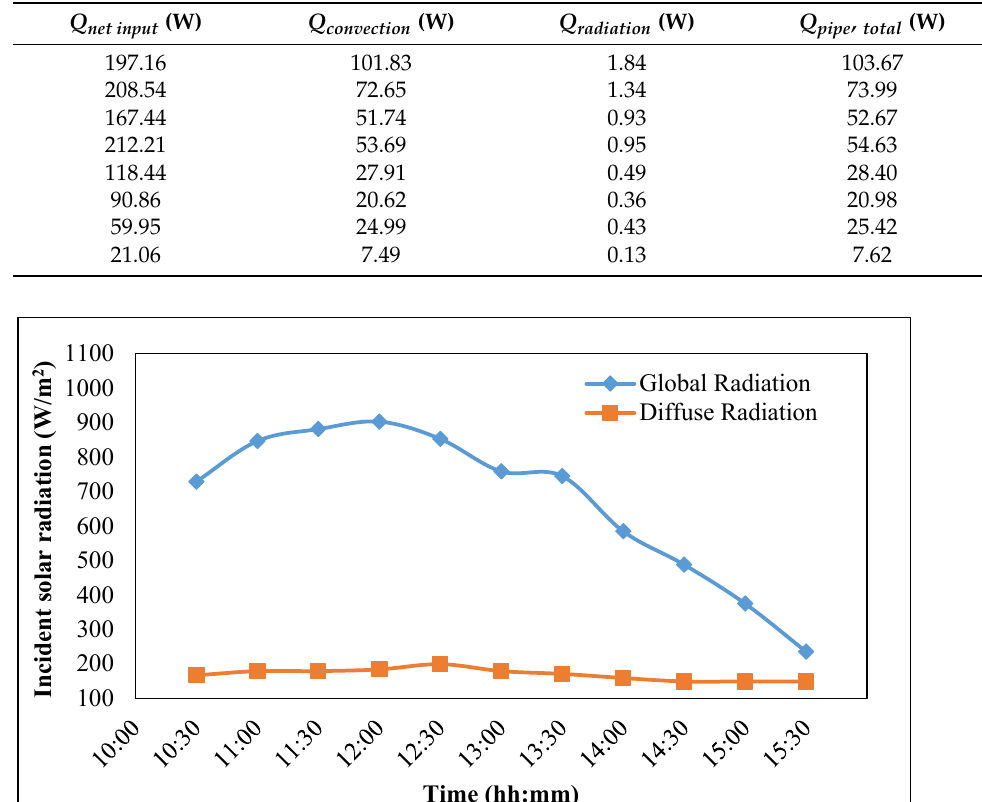
Figure 7. Variation of incident solar radiation during day time.